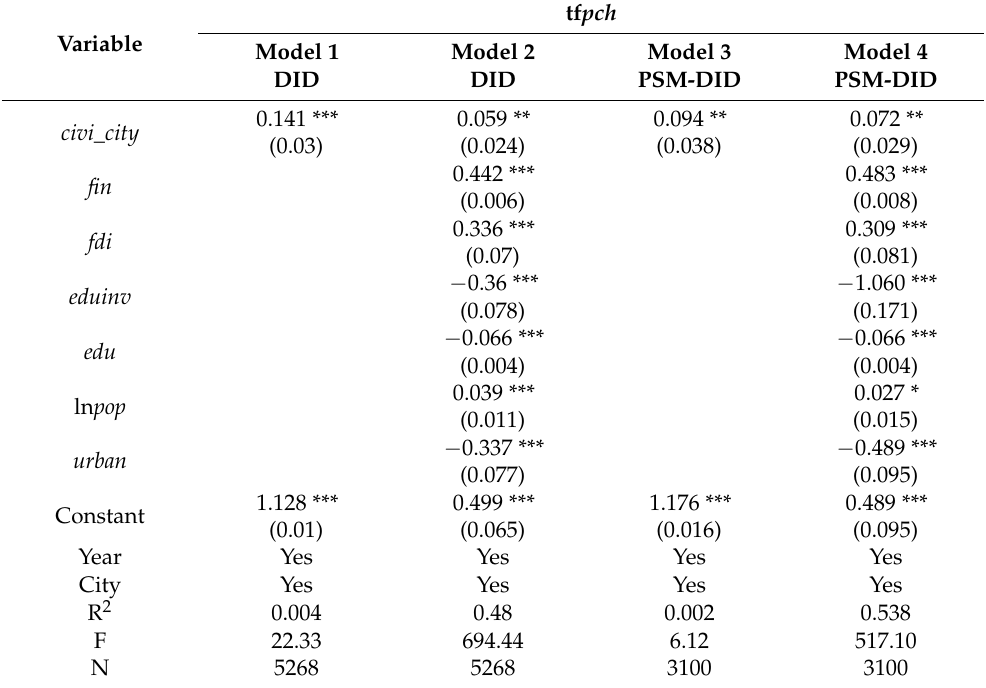
Table 3. Baseline